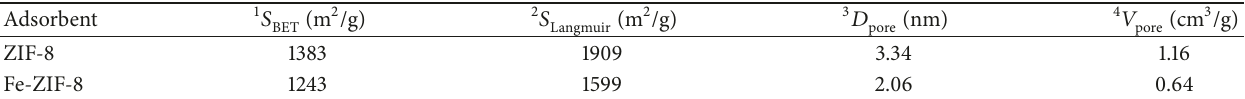
Table 2: Textural properties of ZIF-8